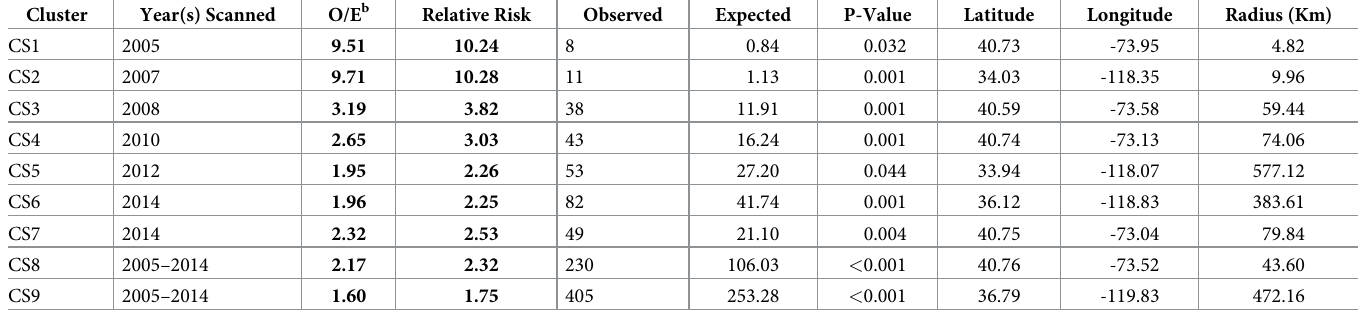
Table 6. Purely spatial clusters identified with the spatial scan statistic using Bernoulli models, where there were statistically significant higher proportions of dog- associated poisoning calls to the APCC a related to cannabinoids in the continental US (2005–2014). Cluster Year(s) Scanned O/E b Relative Risk Observed